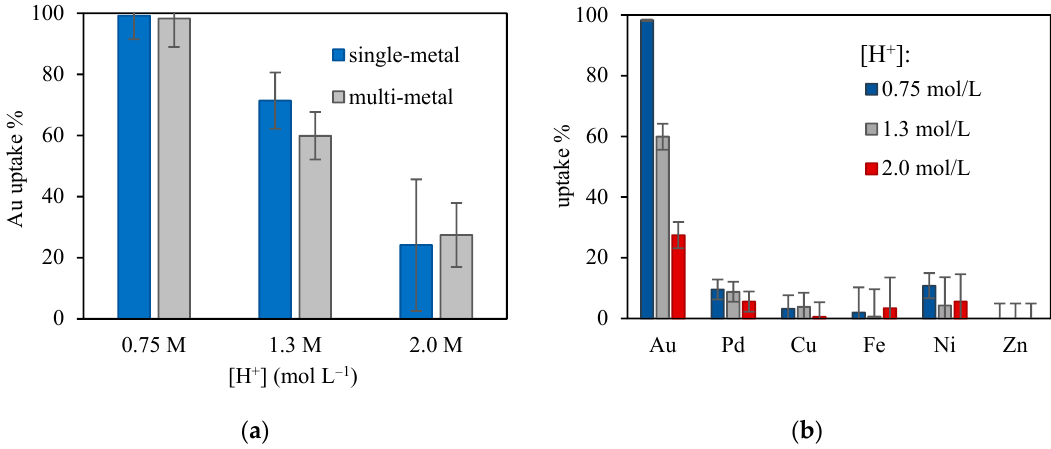
Figure 4. Percentages of metals extracted from simulated liquors containing aqua regia in different H + concentrations by the pine bark tannin resin from (20 °C, S/L 1.0 g L − 1 , initial Au concentration 200 mg L − 1 ): ( a ) comparison of Au uptake from single and multi-metal solutions; ( b ) uptake of metals from the multi-metal solution.